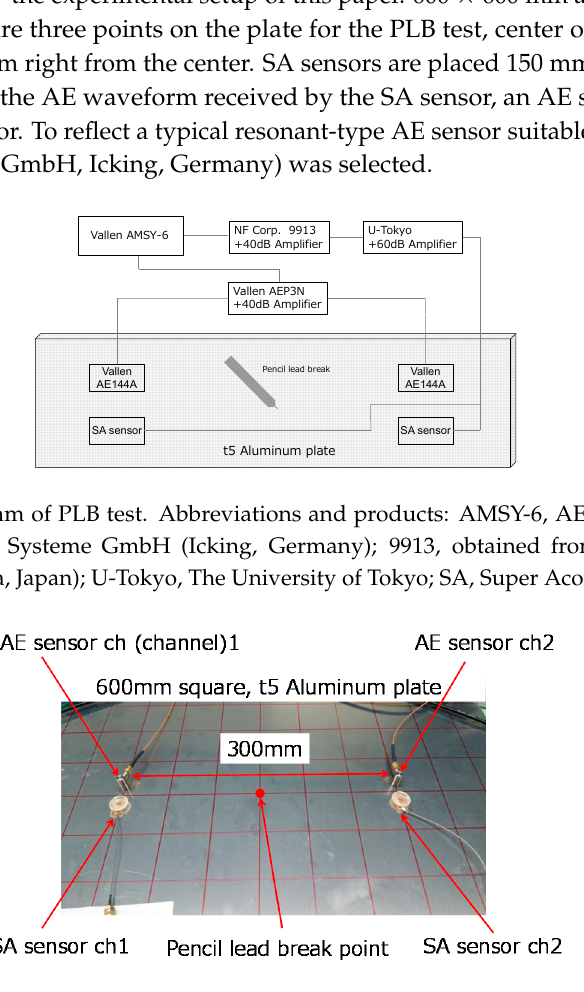
Figure 5. Experimental setup of SA and AE (acoustic emission) sensors.